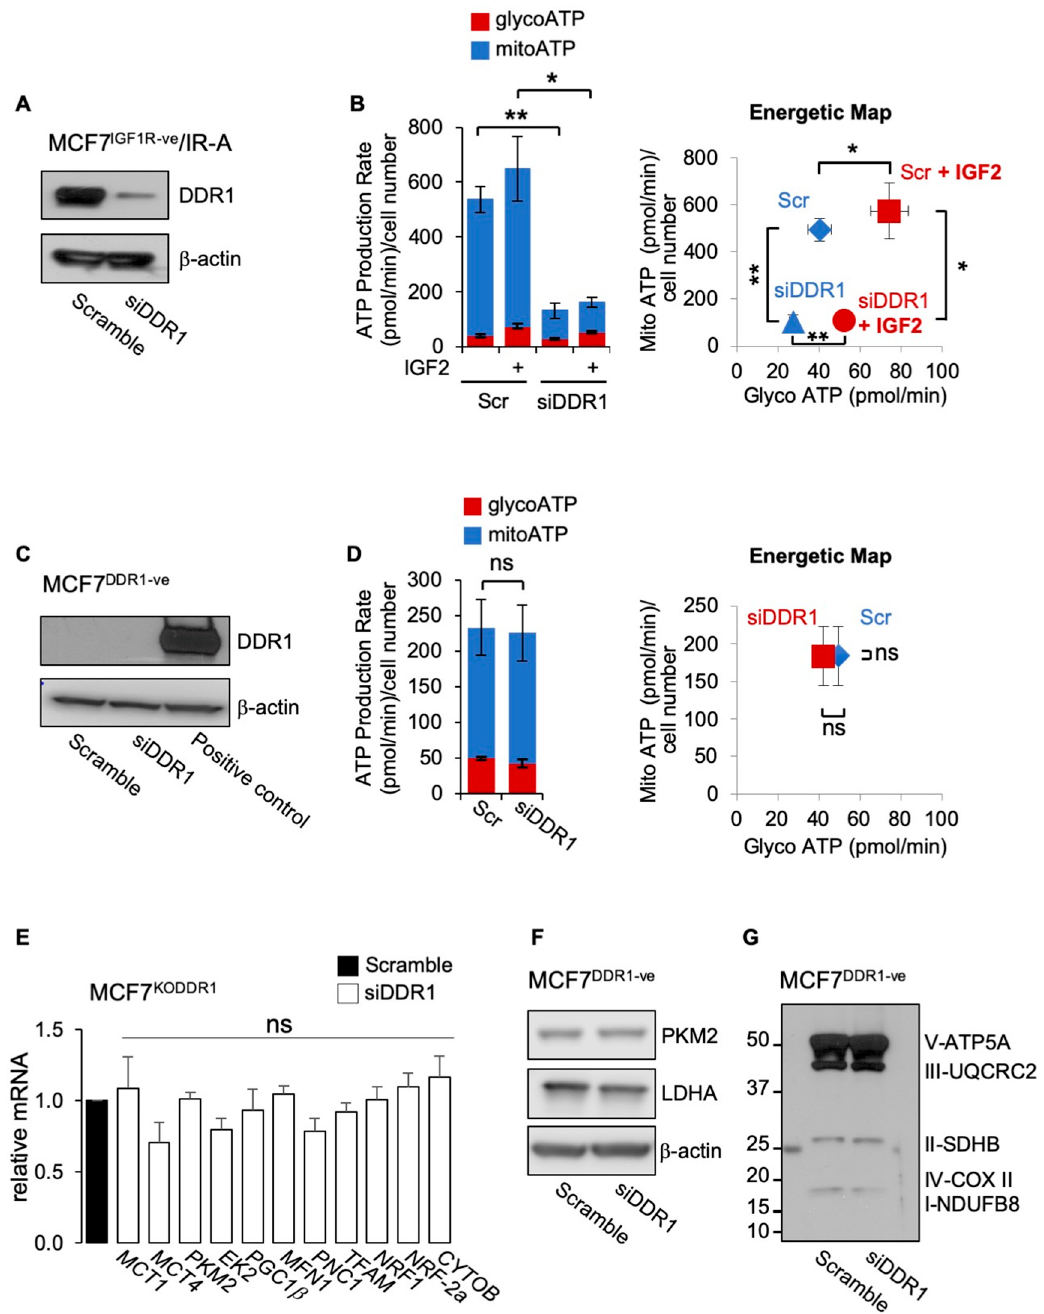
Figure 5. ( A ) MCF7 IGF1R-ve /IR-A cells with or without DDR1 silencing were analyzed by Western immunoblotting for DDR1 expression using polyclonal antibodies against the C-terminus of DDR1, as indicated. β -actin antibody was used as control for protein loading. A representative blot of three independent experiments is shown. ( B ) ATP production rate in MCF7 IGF1R-ve /IR-A cells silenced for DDR1 and in control cells treated with scramble siRNAs, upon stimulation with 100 nM IGF2 for 48 h. Glycolytic ATP (red columns—glycoATP) and mitochondrial ATP (blue columns—mitoATP) production rates were evaluated according to the manufacturer’s instructions as described above (Agilent ATP test). The presented histogram (left panel) and the energetic map (right panel) show the mean and range from three independent experiments. ( C ) MCF7 DDR1-ve cells were analyzed by Western immunoblot for DDR1 expression using polyclonal antibodies against the C-terminus of DDR1, as indicated. A positive control is also shown. β -actin antibody was used as control for protein loading. A representative blot of three independent experiments is shown. ( D ) ATP production rate in MCF7 DDR1-ve silenced for DDR1 and in control cells treated with scramble siRNAs. The presented histogram (left panel) and the energetic map (right panel) show the mean and range from three independent experiments. ( E ) MCF7 DDR1-ve cells and parental MCF7 Cas9